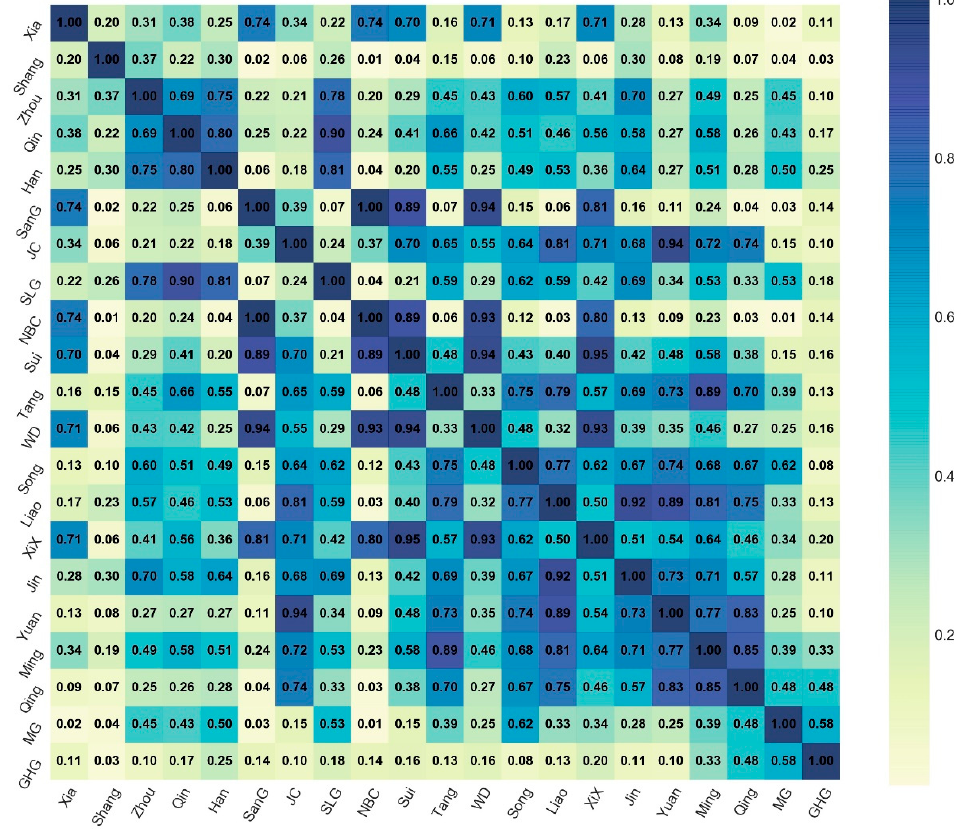
Figure 4. Similarity measurement of the distribution of cultural relics in different dynasties.